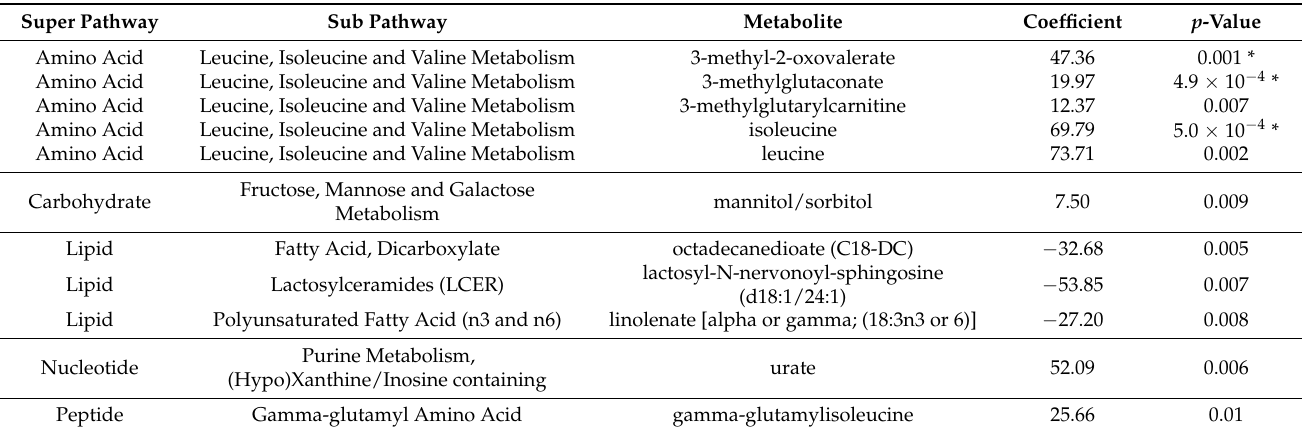
Table 5. Metabolites associated with RIT for patients with intermediate AMD ( p -value <